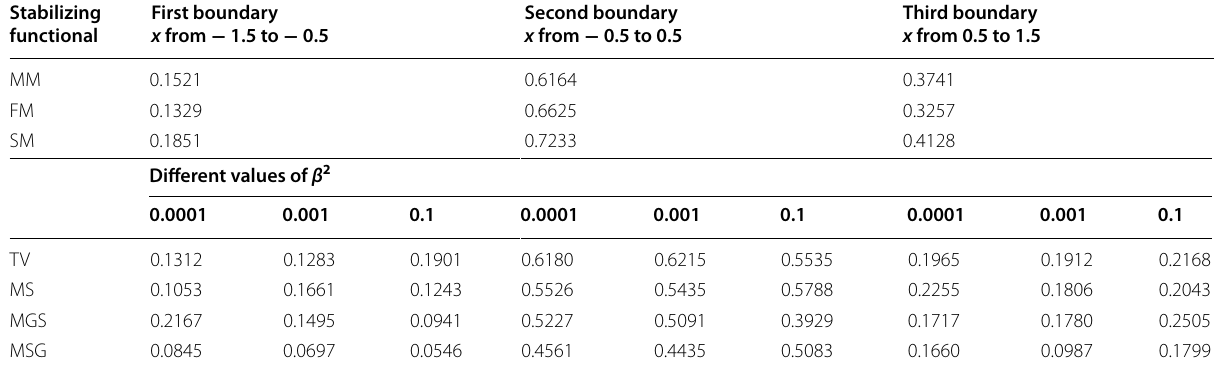
Table 4 RMS model recovery around each boundary of the 1D-layered model B (Fig. 2b) Stabilizing functional